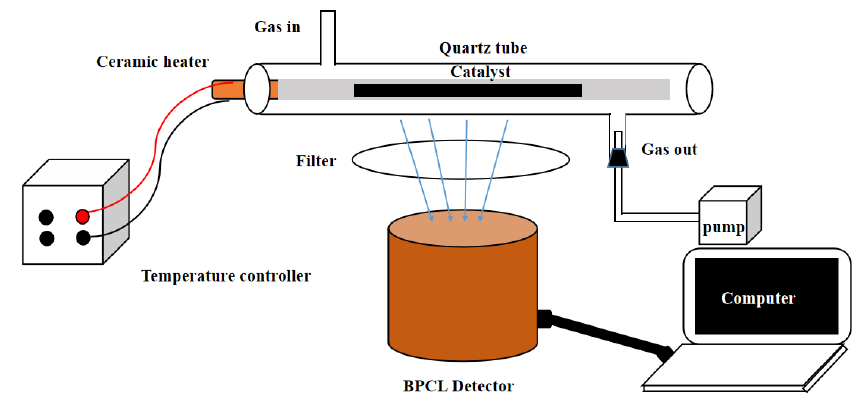
Figure 1. Schematic diagram of CTL sensor experimental device.